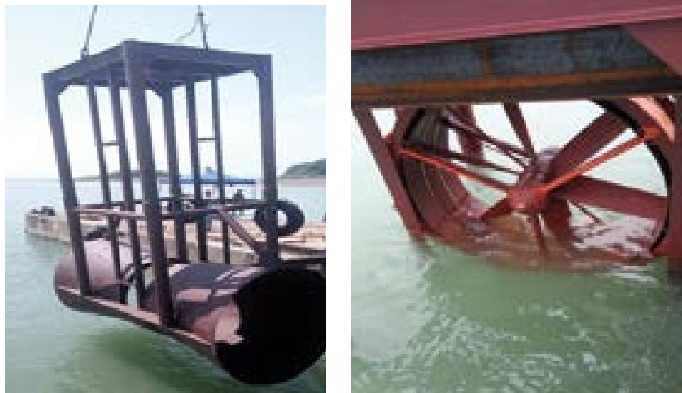
Figure 34. The flange-driven TCPGS. Reproduced from [80].